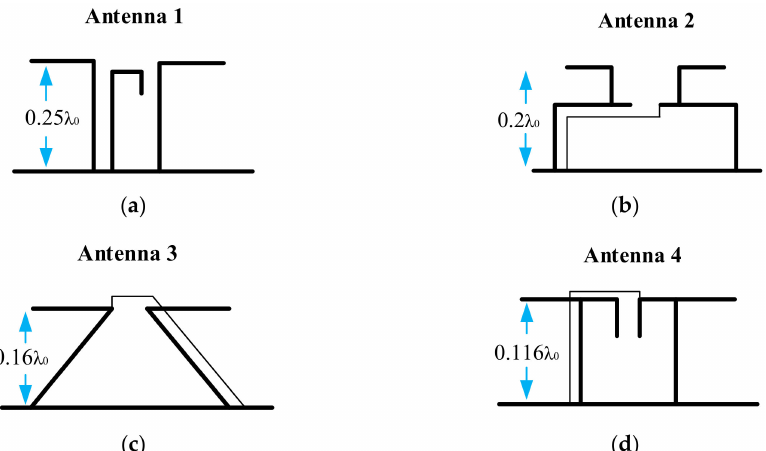
Figure 1. A depiction of the current low-profile techniques for an ME dipole antenna. ( a ) antenna 1; ( b ) antenna 2; ( c ) antenna 3; ( d ) antenna